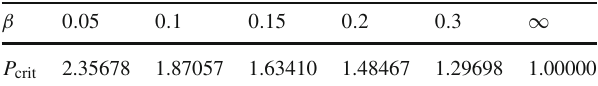
Table 1 Data of critical value of magnetic charge P crit for different β with fixed M = 1. The critical value of magnetic charge decreases as the BI effect weakens until β = ∞ , when P crit becomes the same as magnetically charged RN BH